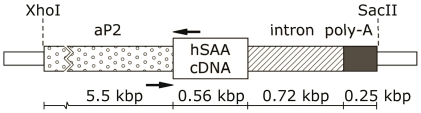
Generation of transgenic mice overexpressing hSAA in adipose tissue.A schematic representation of the aP2 promoter-hSAA fusion gene. Human SAA1 cDNA was ligated to the aP2 promoter/enhancer as described in “Methods”. Dotted box aP2 promoter, hatched box, rabbit β-globin intron, grey box, polyadenylation signal. Restriction enzyme digestion with XhoI and SacII enzymes generated fragments of 7.2 kilobases that were used in pronuclei injections. Locations of genotyping primers are indicated with arrows.